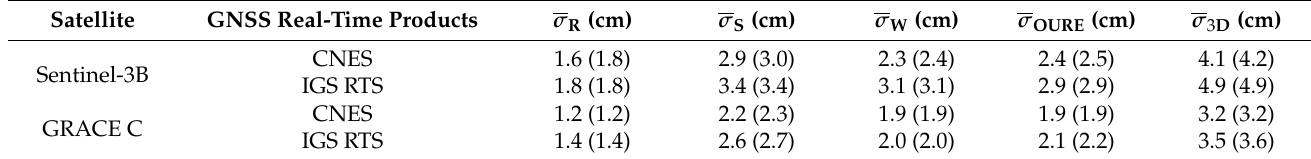
Table 4. Averaged RMS of the orbital errors and the OUREs for Sentinel-3B and GRACE C using different real-time GNSS products. The results without outlier exclusions are given in parentheses.